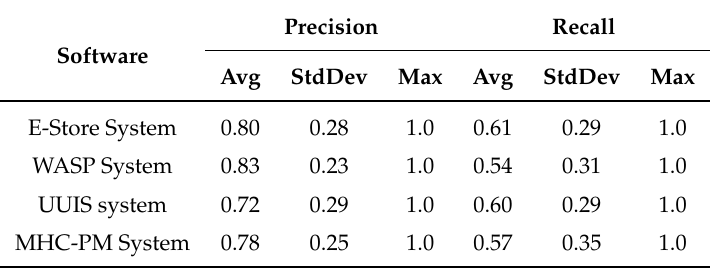
Table 3. Statistics on precision and recall of the identified clusters for each software product.